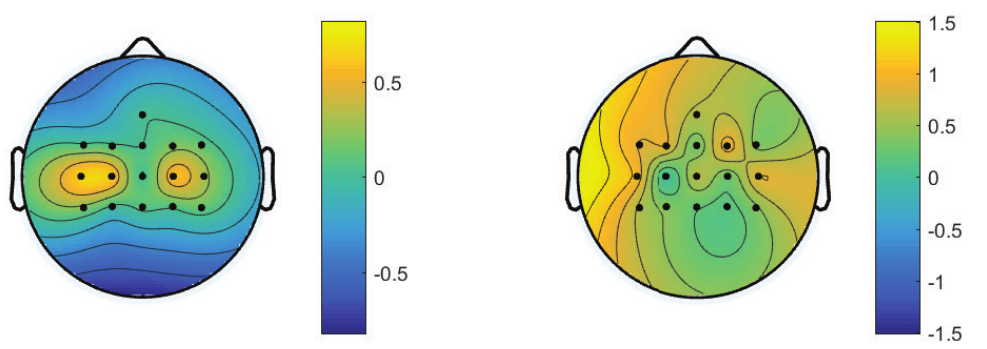
Figure 7. Scalp topographies to show the feature representation of the SVMbased method ( left panel ) and the CNN-based method ( right panel ) for the decoding of the left and right hand MI with 16 EEG